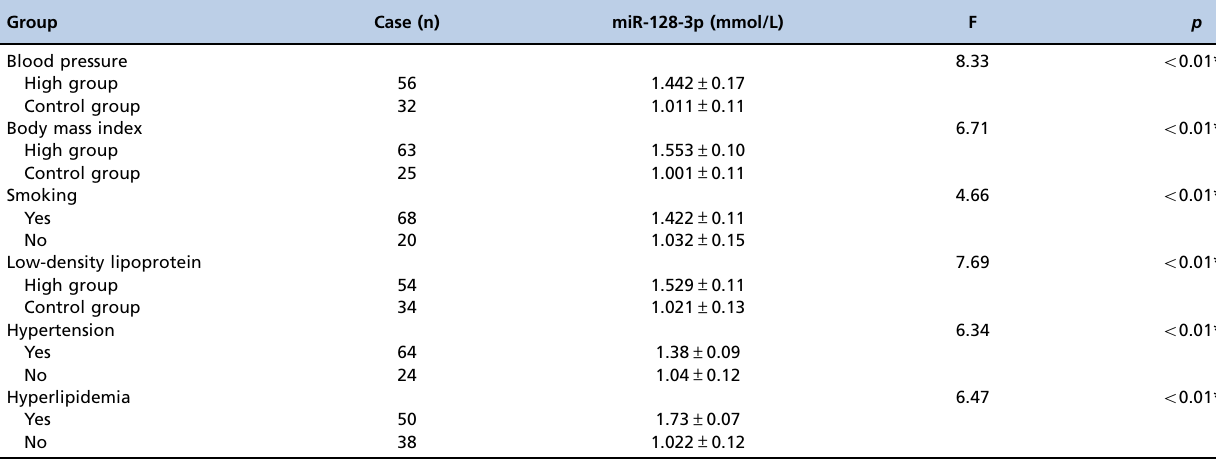
** p o 0.01. Table 3 - Hierarchical analysis of miR-128-3p.